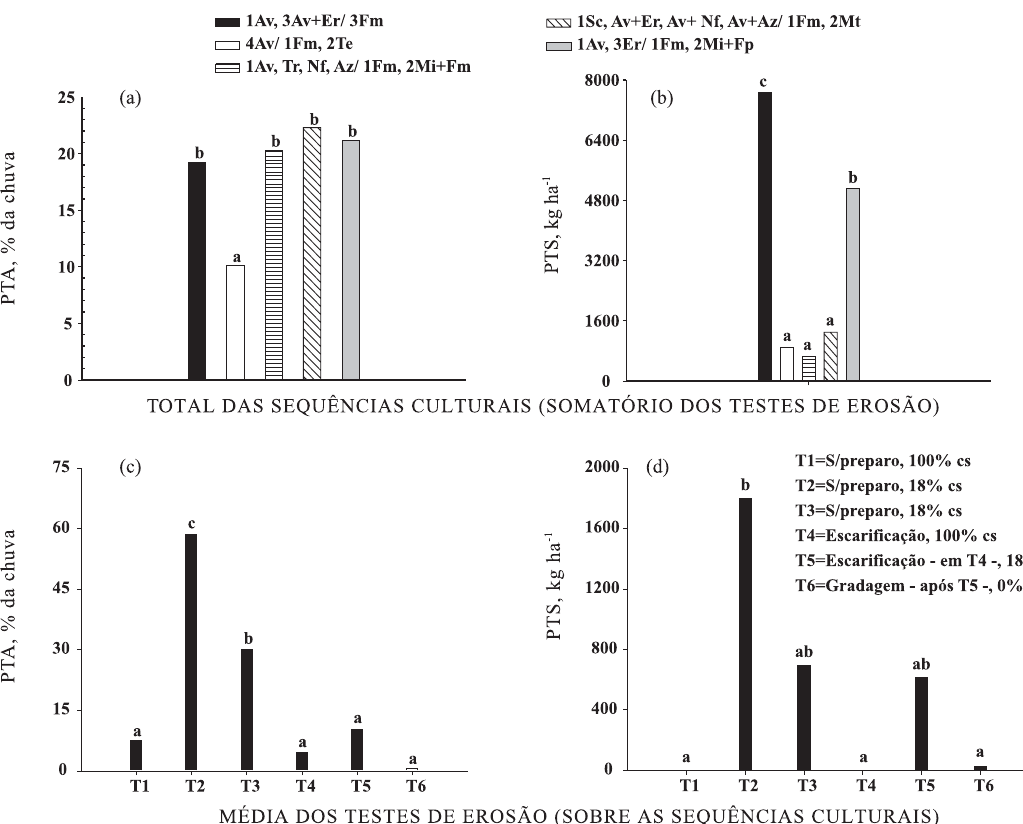
Figura 2. Perda total de água (PTA) e perda total de solo (PTS) para as sequências culturais – somatório dos testes de erosão (a e b, respectivamente), e para os testes de erosão – médias das sequências culturais (c e d,